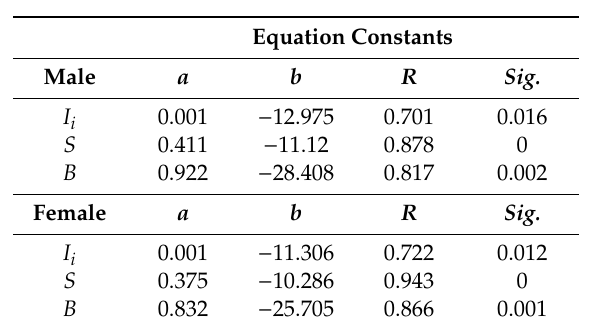
Figure 6. The first choice of di ff erent simulated colors by Empoasca onukii adults: Each experiment for males or females was repeated five times. Tea leaves of di ff erent leaf age are numbered with i ( i = 1–11) from the top to bottom of a tea shoot (see detail in Figure 1). On the x -axis, the numbers ( i = 1–11) are 11 simulated colors based on HSB parameters (see detail in Figure 5), the number 12 ( i = 12) represents the control, and the blank space ( i = 13) shows when leafhoppers had no choice of color. * A significant di ff erence between the males and females ( p < 0.05, independent-samples t -test). Mean values with the same letters are not significantly di ff erent ( p > 0.05) within the male (uppercase) or female (lowercase) histograms, and those with di ff erent letters indicate a significant di ff erence ( p < 0.05, one-way analysis of variance). Table 2. Constants of the linear relationships between N i and the normalized reflectance intensity ( I i ), color parameters S and B of the host